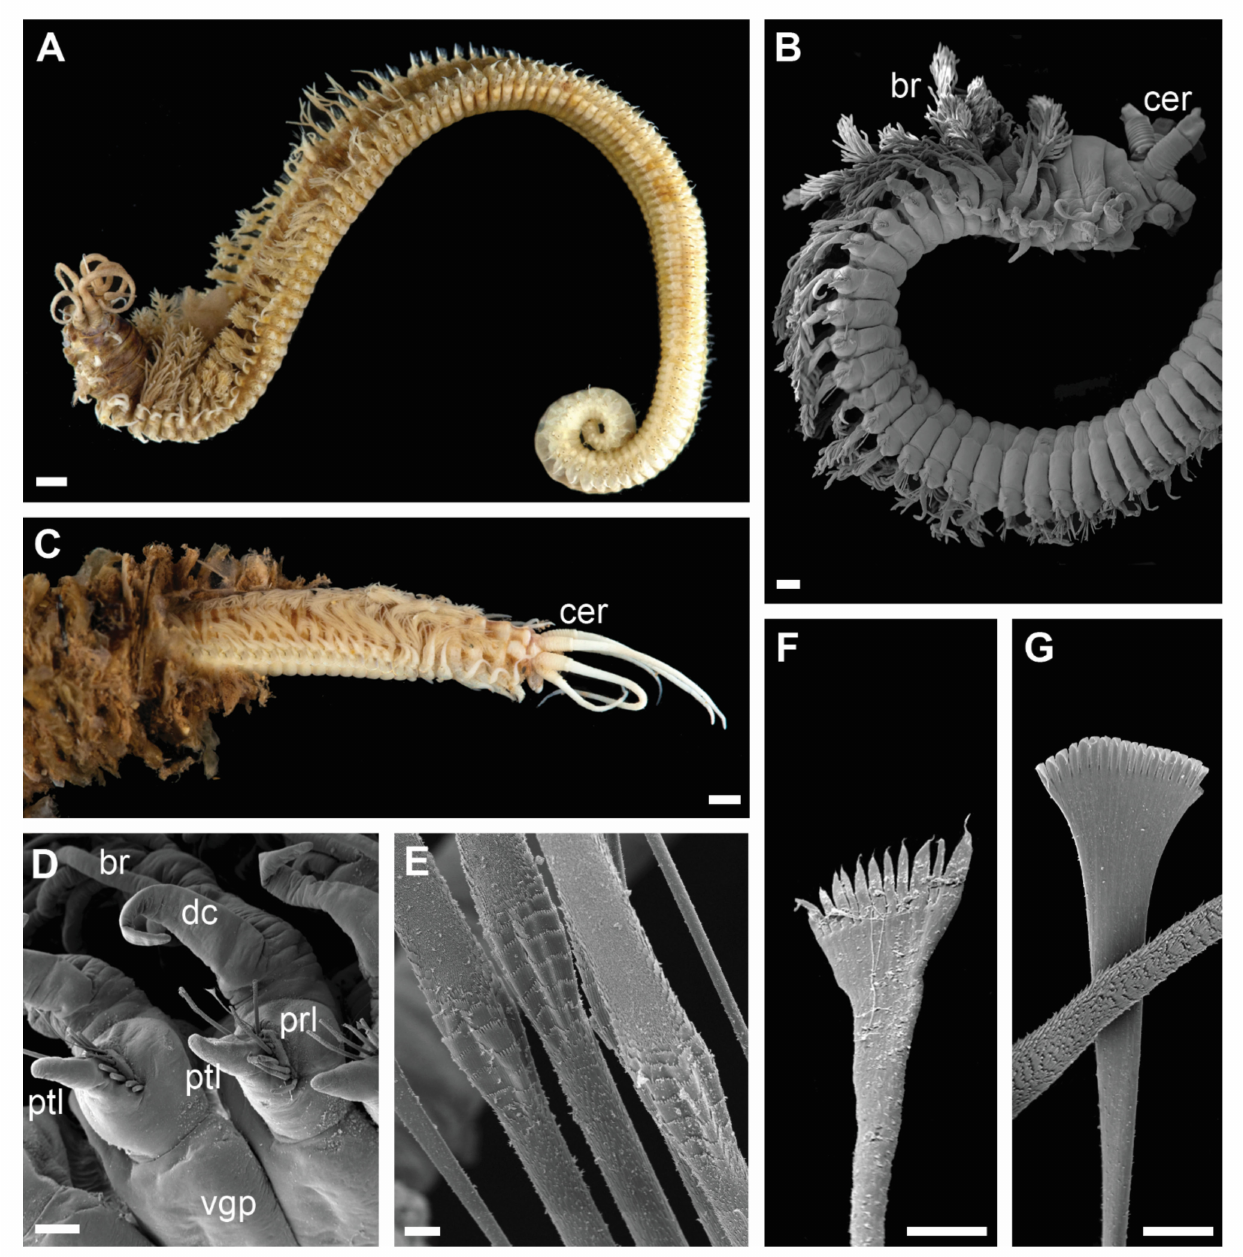
Figure 3. Morphology of Diopatra species representing Clade 2. ( A , C )—light microscopy photographs; ( B , D – F )—scanning electron microscopy images. ( A ): Diopatra marocensis . ZMBN91363, lateral view; ( B ): Diopatra sp. 10 ZMBN126797, anterior fragment, lateral view; ( C ): D. marocensis ZMBN91378, anterior fragment showing color pattern, lateral view; ( D ): Diopatra sp. 10 ZMBN126797, anterior parapodia, lateroventral view; ( E ): The same, limbate chaetae with shelf serration; ( F ): Diopatra sp. ZMBN145681, pectinate chaeta from anterior segments; ( G ): The same from posterior seg- ments. br—branchia; cer—ceratophore; dc—dorsal cirrus; prl—prechaetal lobe; ptl—postchaetal lobe; vgp—ventral glandular pad. Scale bars: ( A , C )—1 mm; ( B )—300 µ m; ( D )—100 µ m; ( E – G )—10 µ